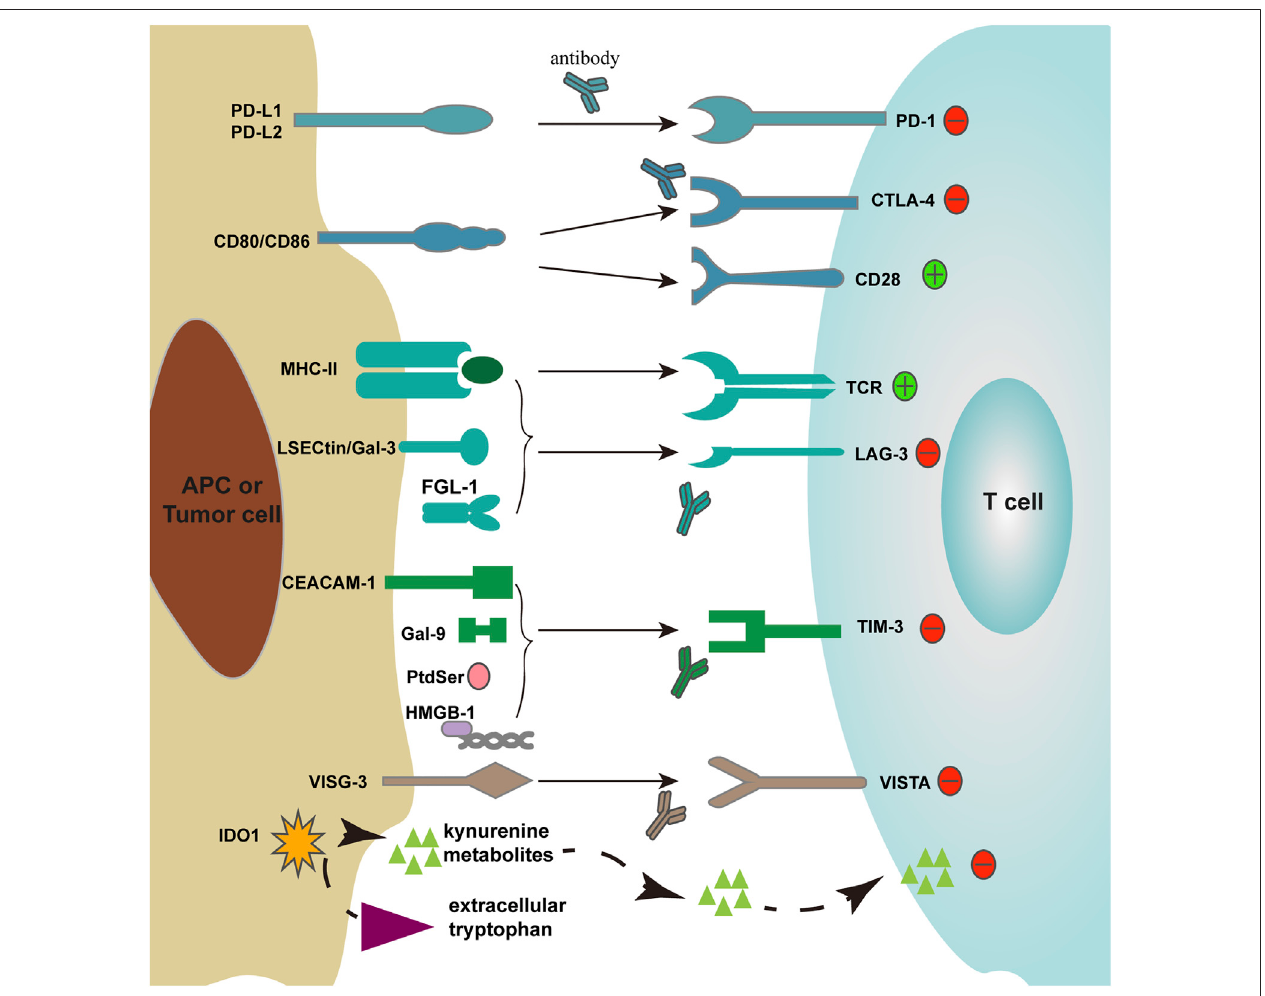
FIGURE1| Immunecheckpointreceptorsandtheirligands.TwosignalsparticipateinT-cellactivation:1)TcellsrecognizeantigenpresentedbyMHC-IImolecules on APCs through TCR; 2) T cells accept costimulatory signals CD80/CD86 through CD28.